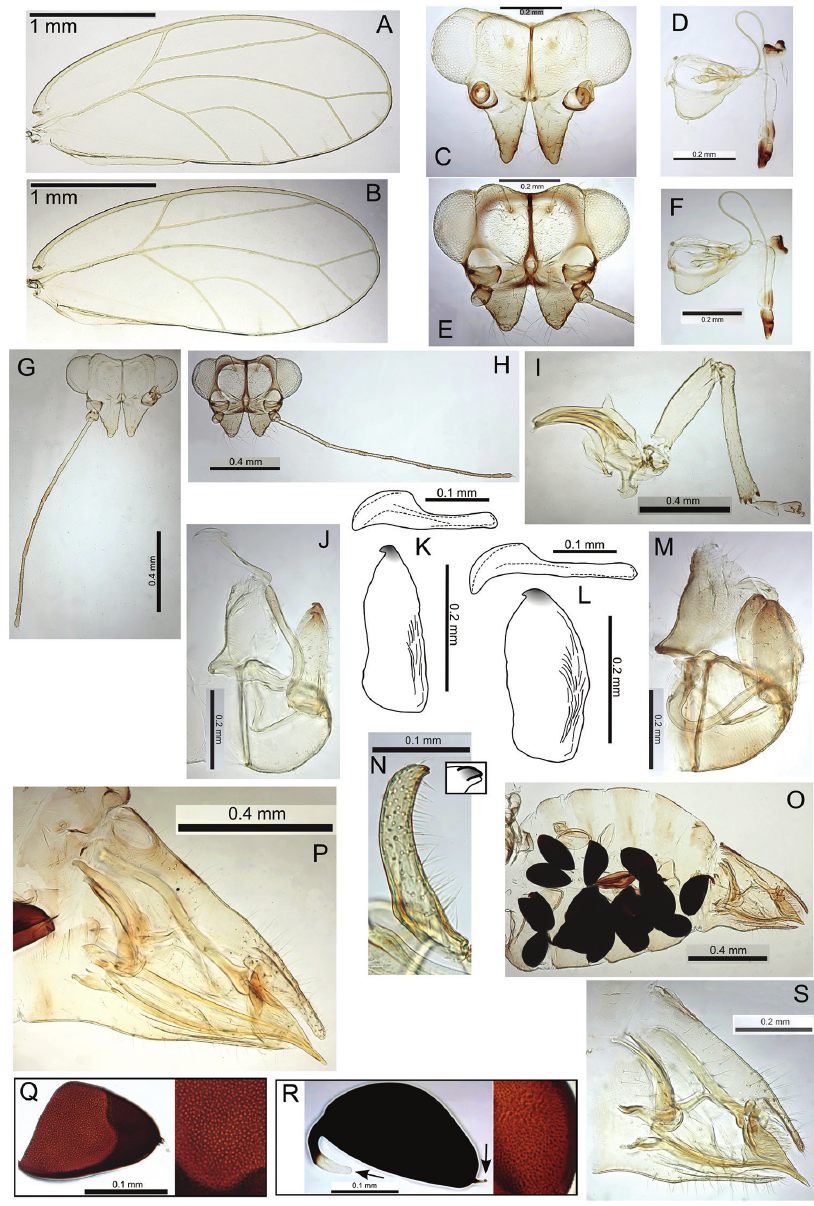
Figure 36. Pariaconus molokaiensis . A, B fore wing: A form molokaiensis B form laka C, D form molokaiensis : C head D proboscis E, F form laka : E head F proboscis G, H head and antenna: G form molokaiensis H form laka I hind leg J, K form molokaiensis : J male terminalia K aedeagus and paramere L, M, N, O, P, Q form laka : L aedeagus and paramere M male terminalia N paramere (posterior view) with apex detail (inset) O female abdomen (with eggs) and terminalia P female terminalia Q eggs showing microsculpturing R, S form molokaiensis : R eggs (pedicel and tail indicated, microsculpturing detailed) S female